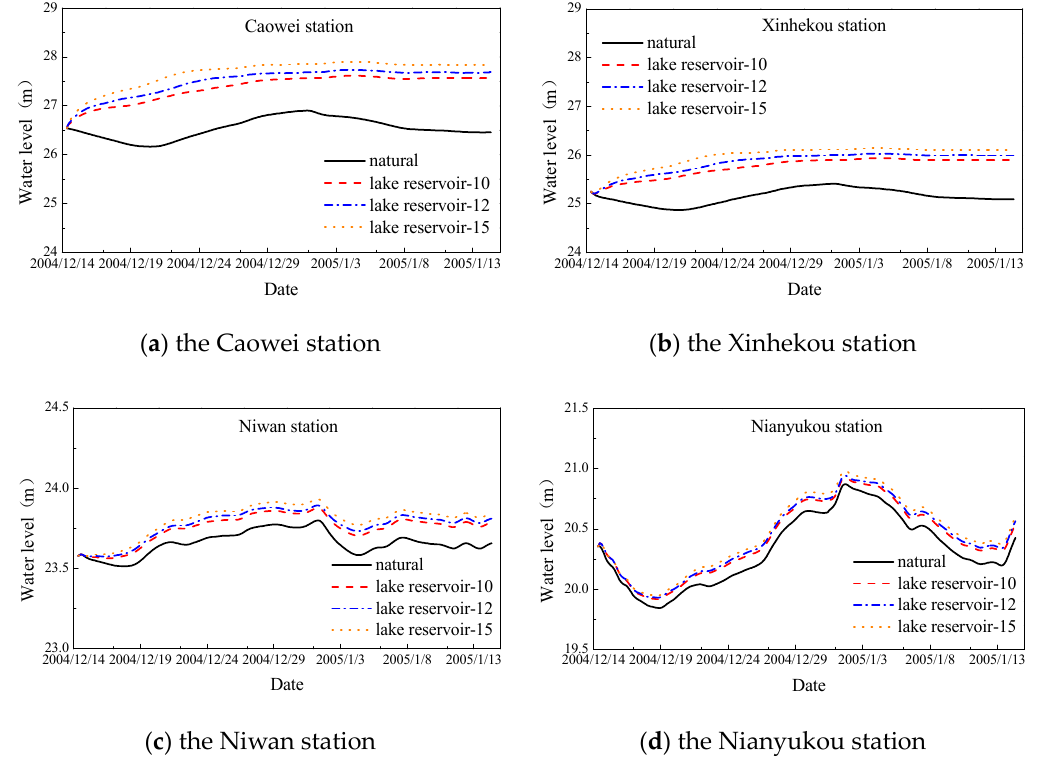
Figure 10. The time series of water elevation at different sites under different design depth during the dry season.